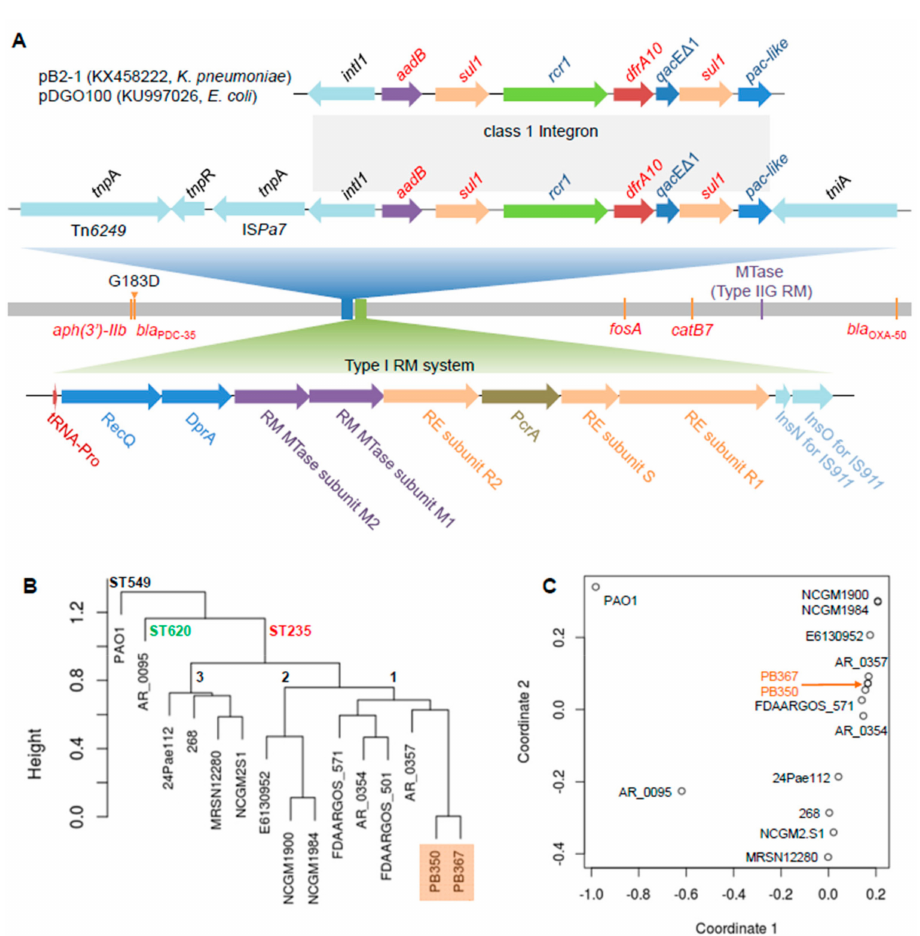
Figure 1. Comparative genome analysis of P. aeruginosa isolates. ( A ) Schematic genome of the paired P. aeruginosa isolates, PB367 and PB350. Genomic mutation C931,543T (G183D) in β -lactamase gene ( bla PDC-35 ) from PB367 to PB350 is indicated in the chromosome, along with other antimicrobial resistance genes ( aph (3’)-IIb, fos A, cat B7, and bla OXA-50 ) and a gene encoding a putative Type IIG restriction-modification (RM) methyltransferase (MTase) targeting a specific motif AAG m6 AYC. Top: A unique class 1 integron in P. aeruginosa with multidrug resistance (MDR) genes, 100% identical to the ones found in plasmids of K. pneumoniae and E. coli , is located among multiple mobile genetic elements, Tn 6249 , resolvase, IS Pa7 , and tni A.Bottom: AuniqueTypeIRMsystemcomprisedofrestrictionenzymes (RE, subunits R and S) and modification MTases (M1 and M2) putatively targeting a bipartite and asymmetric motif CT m6 AC(N) 5 GGG / C m4 CC(N) 5 GTAG; ( B ) Phylogeny tree of 15 P. aeruginosa isolates, mainly ST235, from kWIP hierarchical clustering using the complete linkage method. PAO1 belonged to ST549, AR_0095 belonged to ST620, and three main sub-ST235 clusters (1–3) are demonstrated; ( C ) Relatedness overview of 15 P. aeruginosa isolates in a plot of metric multidimensional scaling